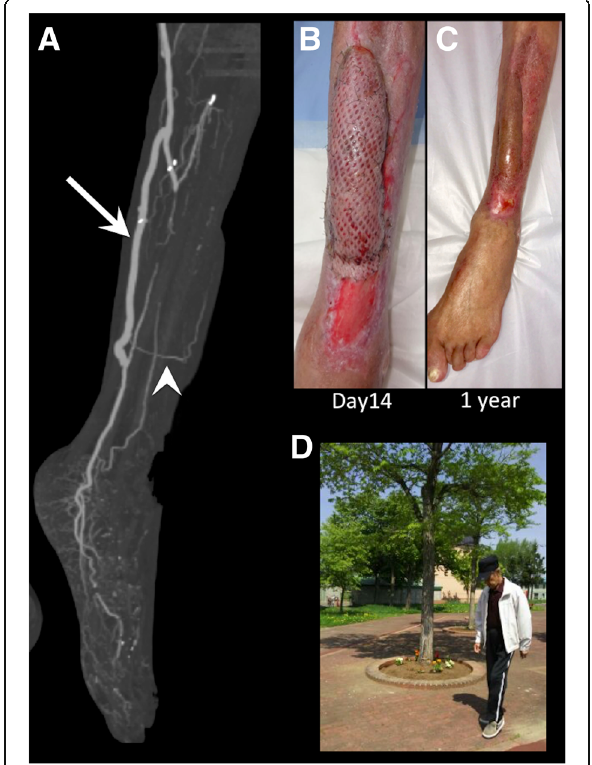
Fig. 3 a Computed tomography after the second surgery showed the patent jump bypass to the distal posterior tibial artery (arrow) and the pedicle of the free gracilis muscle flap (arrowhead). b Postoperative photographs showing the gracilis muscle flap covered with a meshed split-thickness skin graft at postoperative day 14. c Photograph 1 year after muscle flap coverage. d Photograph 1 year after